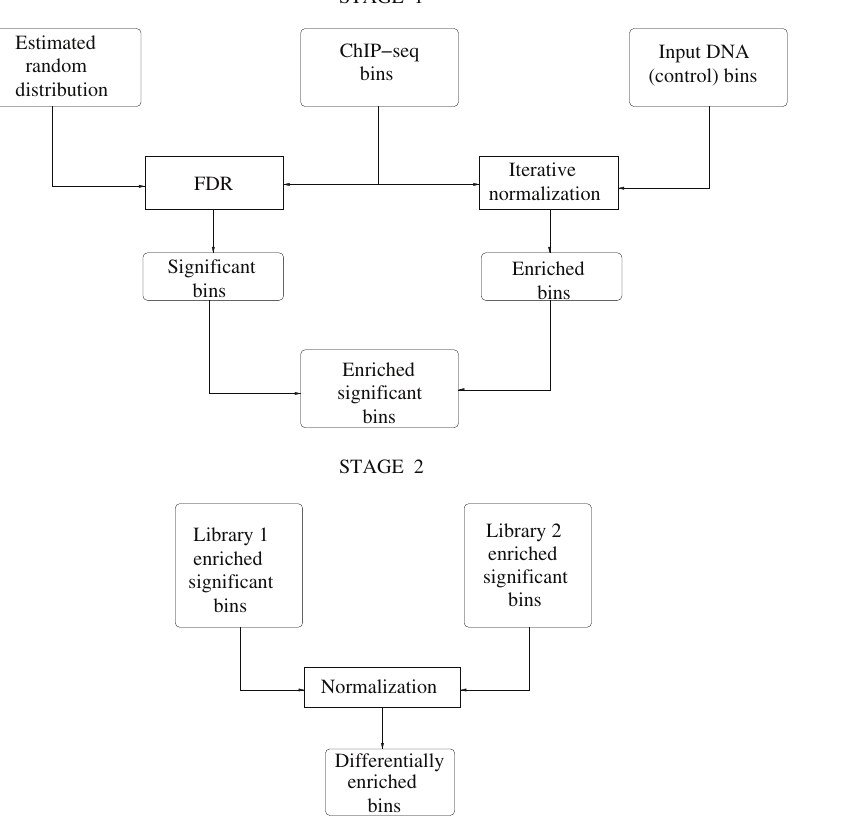
Figure 4. The schematic diagram of the ChIPnorm method. In the first stage one we find the enriched-significant bins by removing various kinds of errors in the data. In the second stage we normalize the two ChIP-seq libraries and find differentially enriched bins.